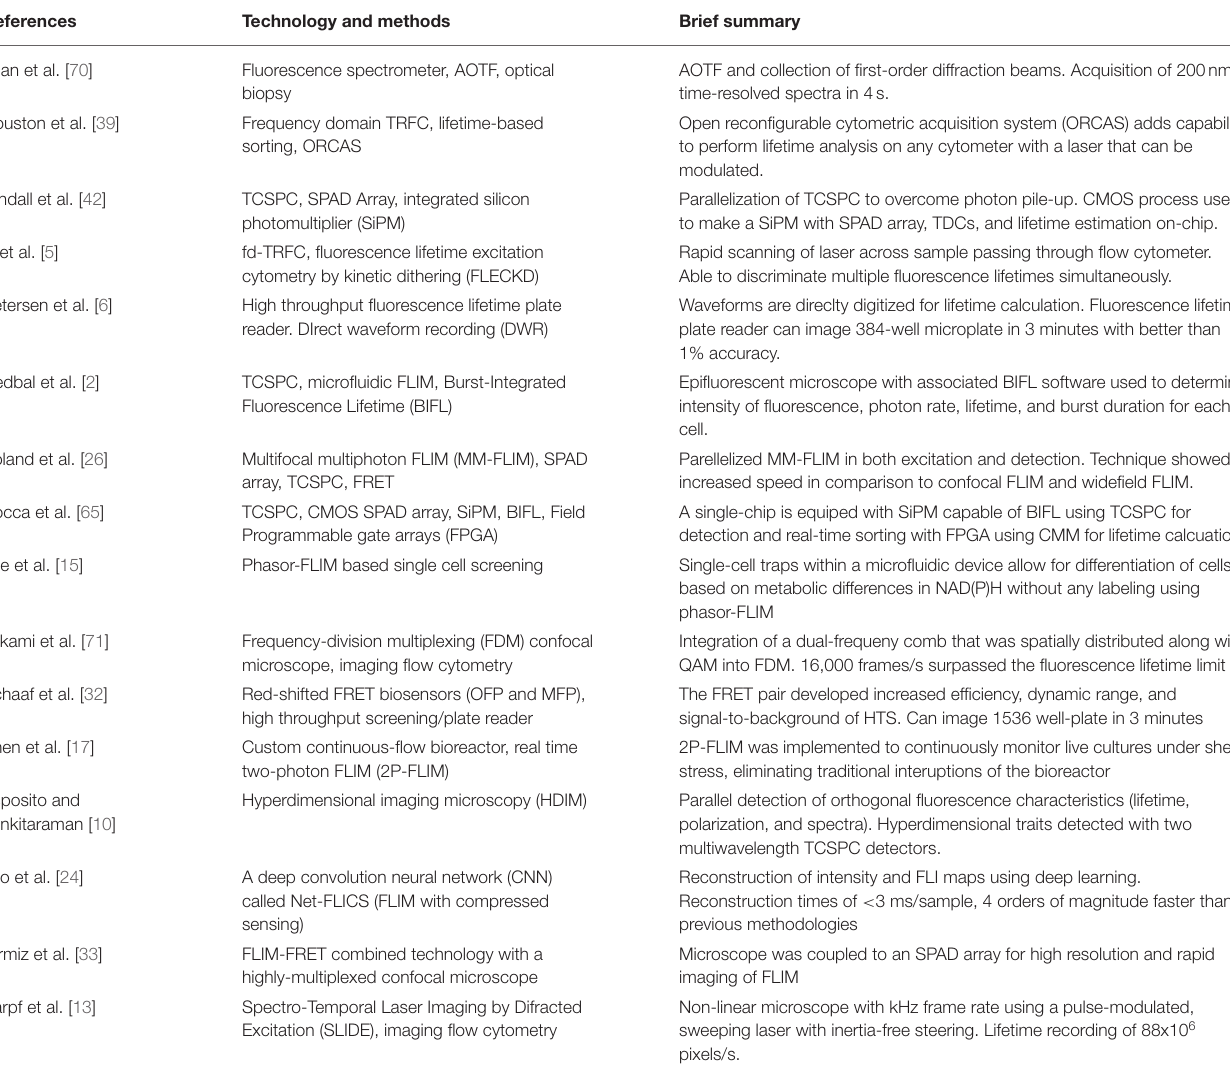
TABLE 2 | Fluorescence lifetime measuring technology and methods in the past